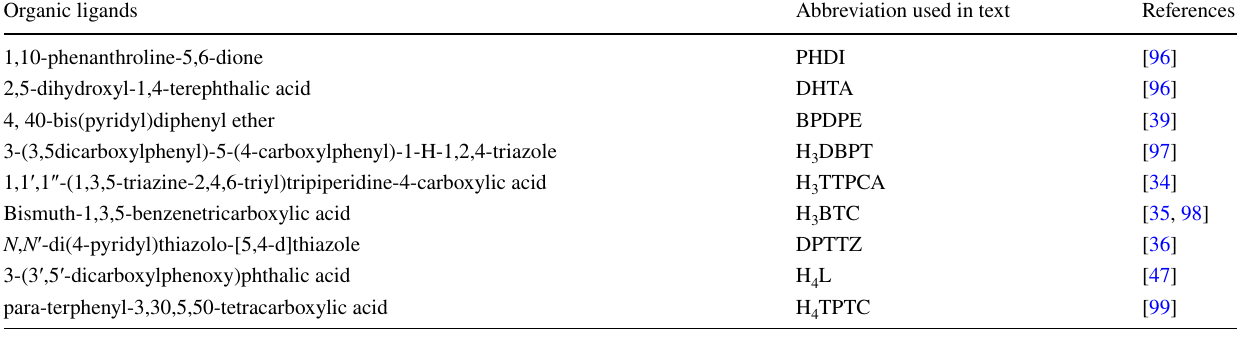
Table 1 Organic ligands that enable photoluminescence Organic ligands